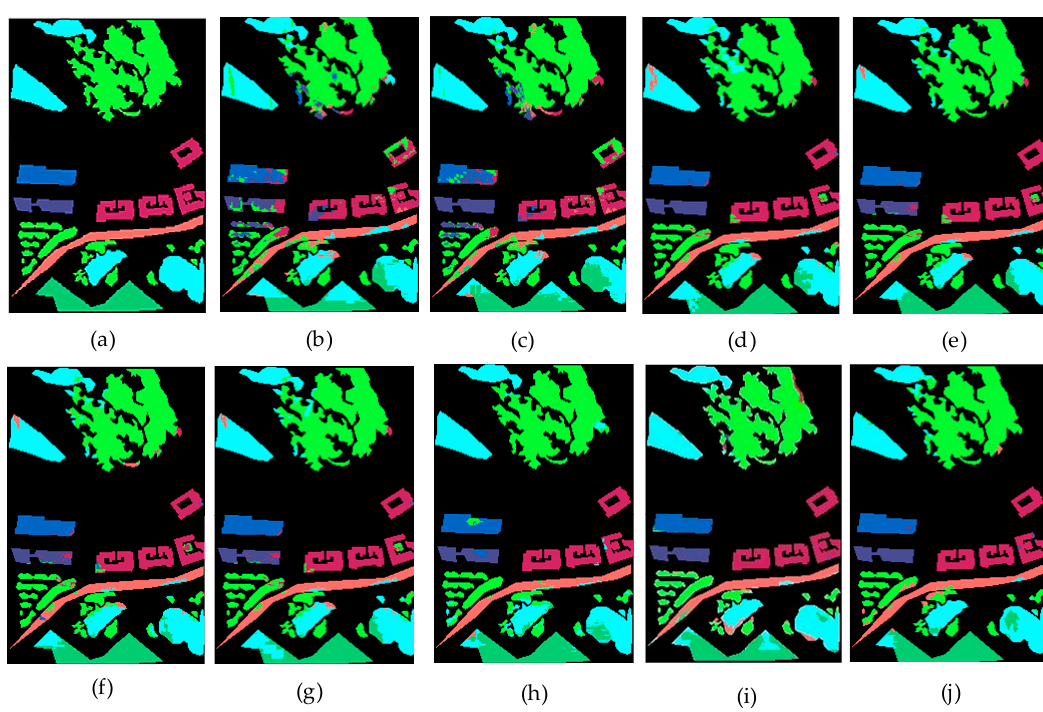
Figure 10. Classification results on Bayview Park data set: ( a ) Ground-truth map; ( b ) Decision Tree; ( c ) SVM; ( d ) KNN; ( e ) Random Forest; ( f ) CNN; ( g ) CapsNet; ( h ) ResNet; ( i ) OctSqueezeNet; ( j ) ResCapNet.